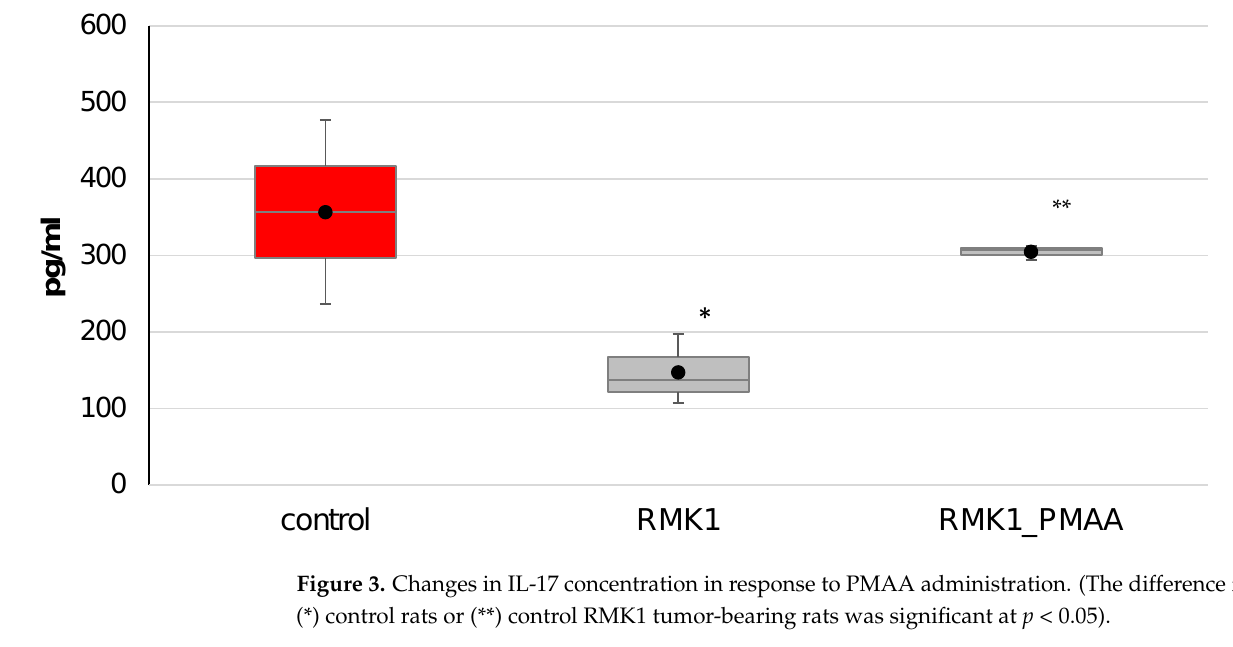
Figure 3. Changes in IL-17 concentration in response to PMAA administration. (The difference from (*) control rats or (**) control RMK1 tumor-bearing rats was significant at p < 0.05). TGF- β1 is a regulatory cytokine that both exerts a suppressor effect and facilitates the neoplastic process in breast cancer cell lines and tissues [24]. A dual function is per- formed by TGF- β1 in tumor progression [ 25]. Acting as a tumor suppressor, TGF- β1 ex- erts an antiproliferative effect in early tumorigenesis. TGF- β1 inhibits cell -cycle progress and facilitates apoptosis, thus exerting a tumor-suppressing effect. Estrogen recep- tor-mediated proliferation is limited by TGF- β1 [ 26]. At the same time, cancer cells are capable of evading the suppressor effect of TGF- β1 at more advanced stages, leading to tumor progression [27,28]. TGF- β1 exerts a stimulatory effect on cancer cells to increase their invasion and metastasis [29].